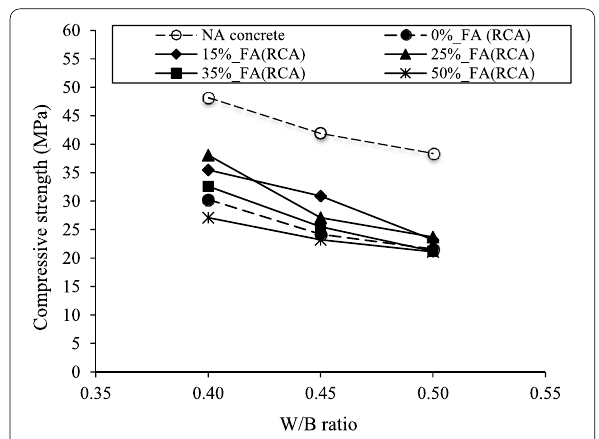
Fig. 2 Effect of W/B ratios on compressive strength of NA and RCA fly ash concretes after 7-year exposure in a marine